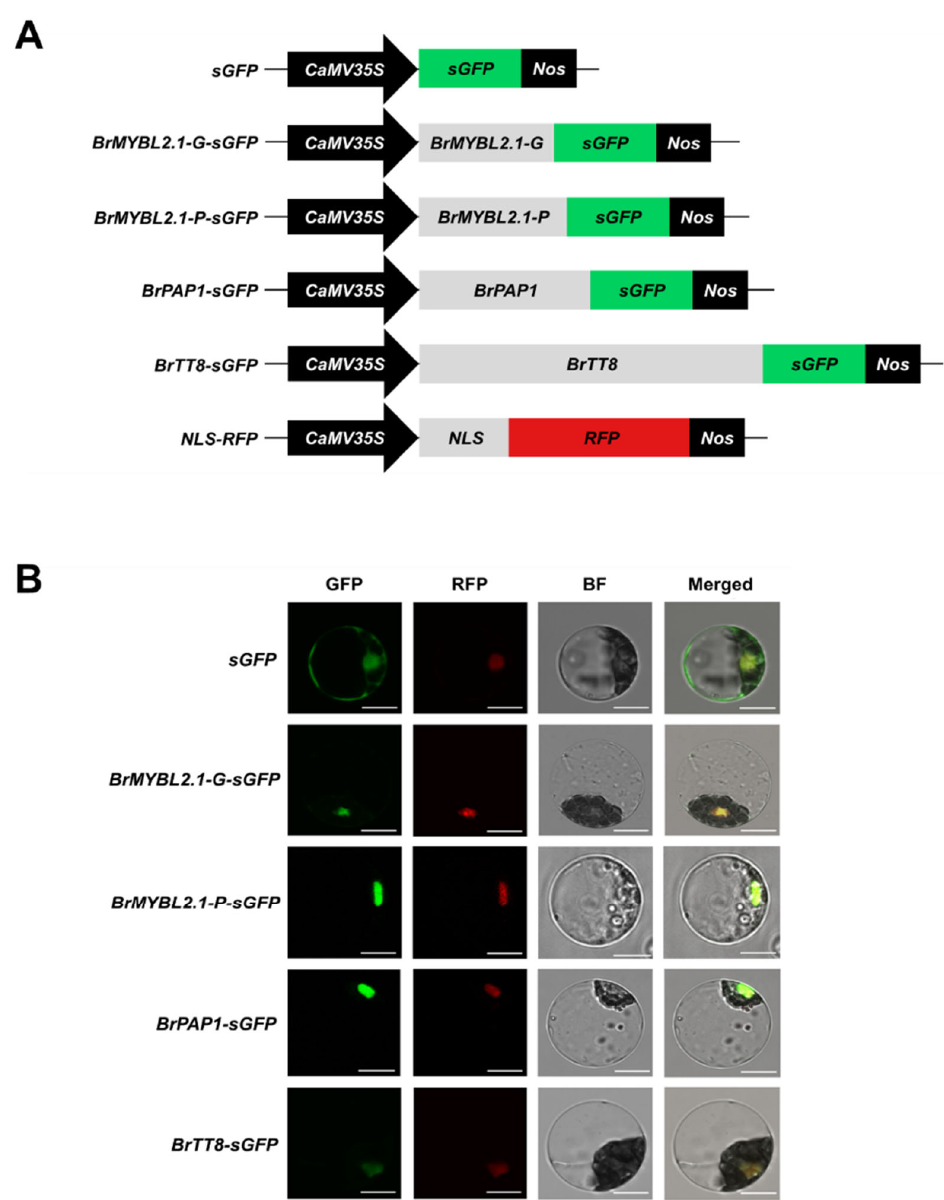
Figure 4. Subcellular localization of BrMYBL2.1 ‐ G, BrMYBL2.1 ‐ P, BrPAP1, and BrTT8 in Arabidopsis leaf protoplasts. ( A ) Schematic diagram of the constructs used in this experiment: CaMV35S , cauliflower mosaic virus 35S promoter; sGFP , soluble green fluorescent protein ( GFP ) gene; BrMYBL2.1 ‐ G ‐ sGFP , BrMYBL2.1 ‐ G fused to sGFP ; BrMYBL2.1 ‐ P ‐ sGFP , BrMYBL2.1 ‐ P fused to sGFP ; BrPAP1 ‐ sGFP , BrPAP1 fused to GFP ; BrTT8 ‐ sGFP , BrTT8 fused to sGFP ; NLS ‐ RFP , nuclear localization signal fused to the red fluorescent protein ( RFP ) gene; Nos , nopaline synthase terminator. ( B ) In vivo localization pattern of BrMYBL2.1 ‐ G, BrMYBL2.1 ‐ P, BrPAP1, and BrTT8 in Arabidopsis protoplasts. Representative protoplasts accumulating each fusion protein are shown 16 h after transformation. GFP, GFP fluorescence; RFP, RFP fluorescence; BF, bright field and merged, merged of GFP, RFP, and bright field images. Bars, 10 μ m.